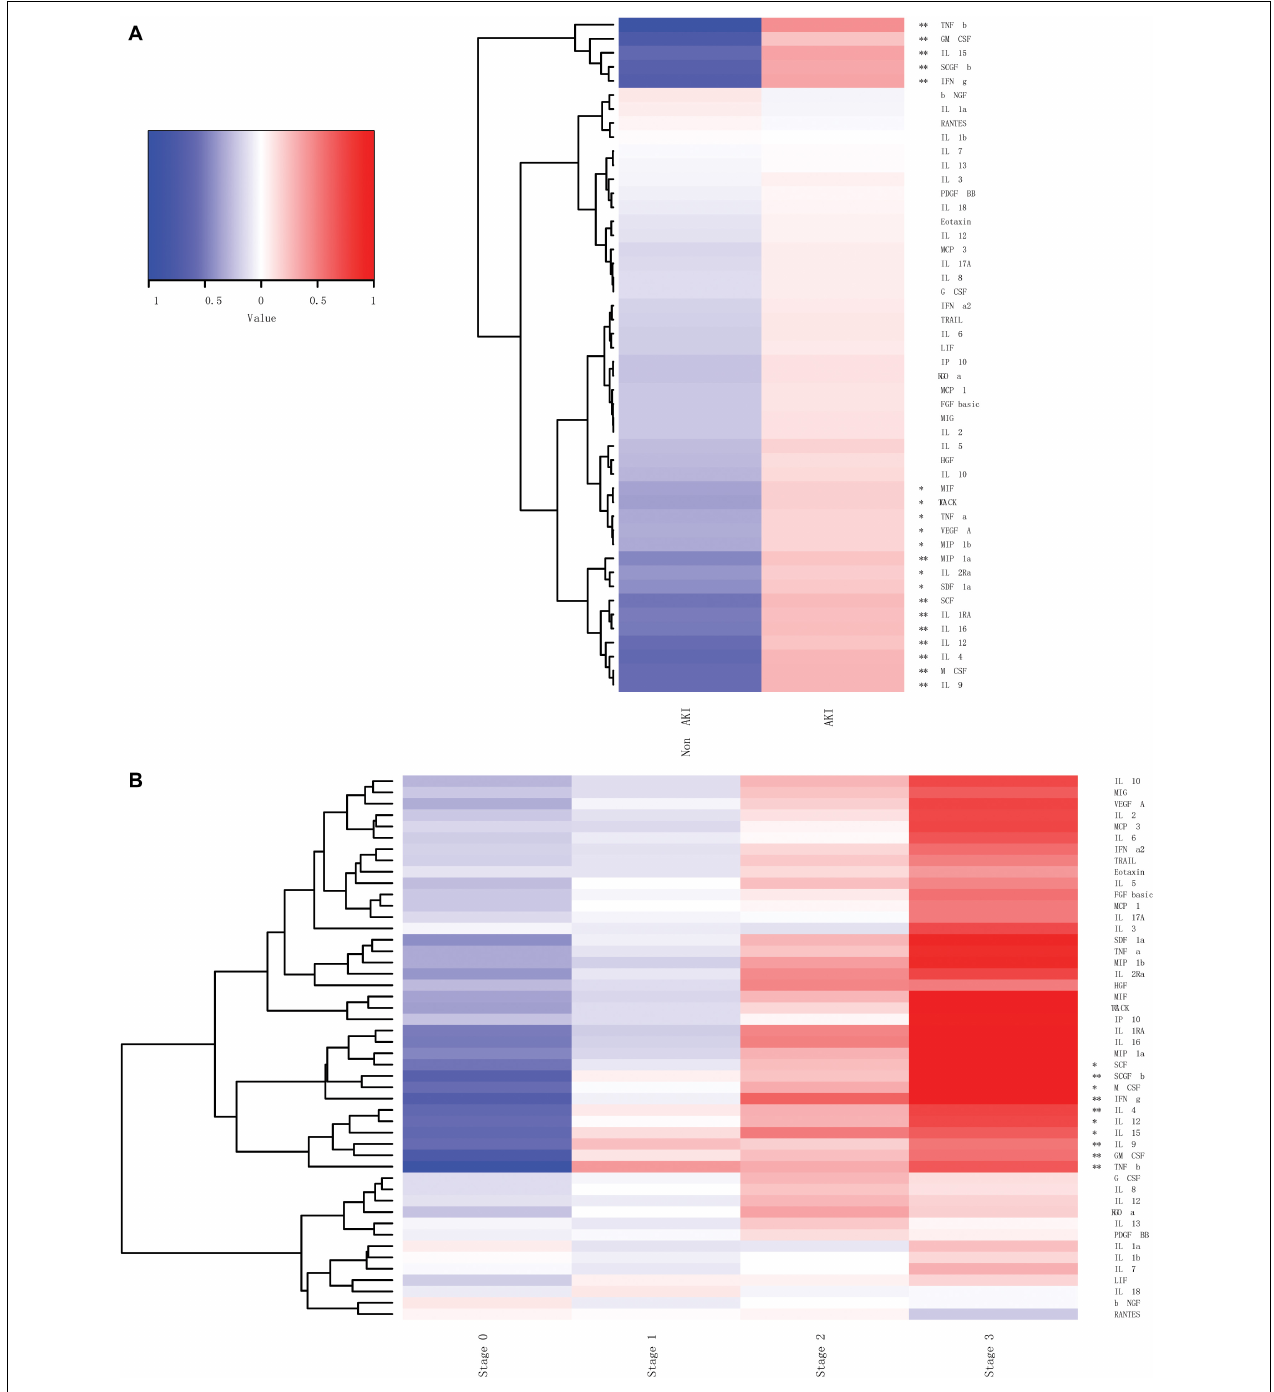
FIGURE 2 | The plasma concentrations of 48 cytokines within 24 h after cardiac surgery. (A) The plasma concentrations of 20 cytokines were significantly different between the AKI and non-AKI groups. (B) The plasma concentrations of these 48 cytokines between the groups with different AKI stages. * p < 0.05, ** p < 0.00001.